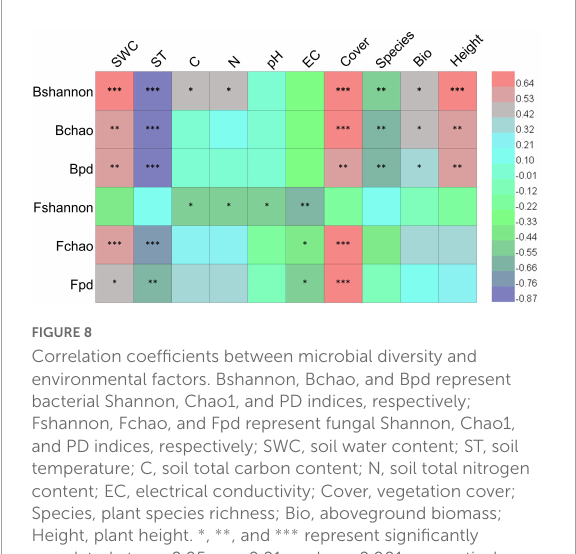
FIGURE8 Correlation coefficients between microbial diversity and environmental factors. Bshannon, Bchao, and Bpd represent bacterial Shannon, Chao1, and PD indices, respectively; Fshannon, Fchao, and Fpd represent fungal Shannon, Chao1, and PD indices, respectively; SWC, soil water content; ST, soil temperature; C, soil total carbon content; N, soil total nitrogen content; EC, electrical conductivity; Cover, vegetation cover; Species, plant species richness; Bio, aboveground biomass; Height, plant height. ∗ , ∗∗ , and ∗∗∗ represent significantly correlated at p < 0.05, p < 0.01, and p < 0.001,